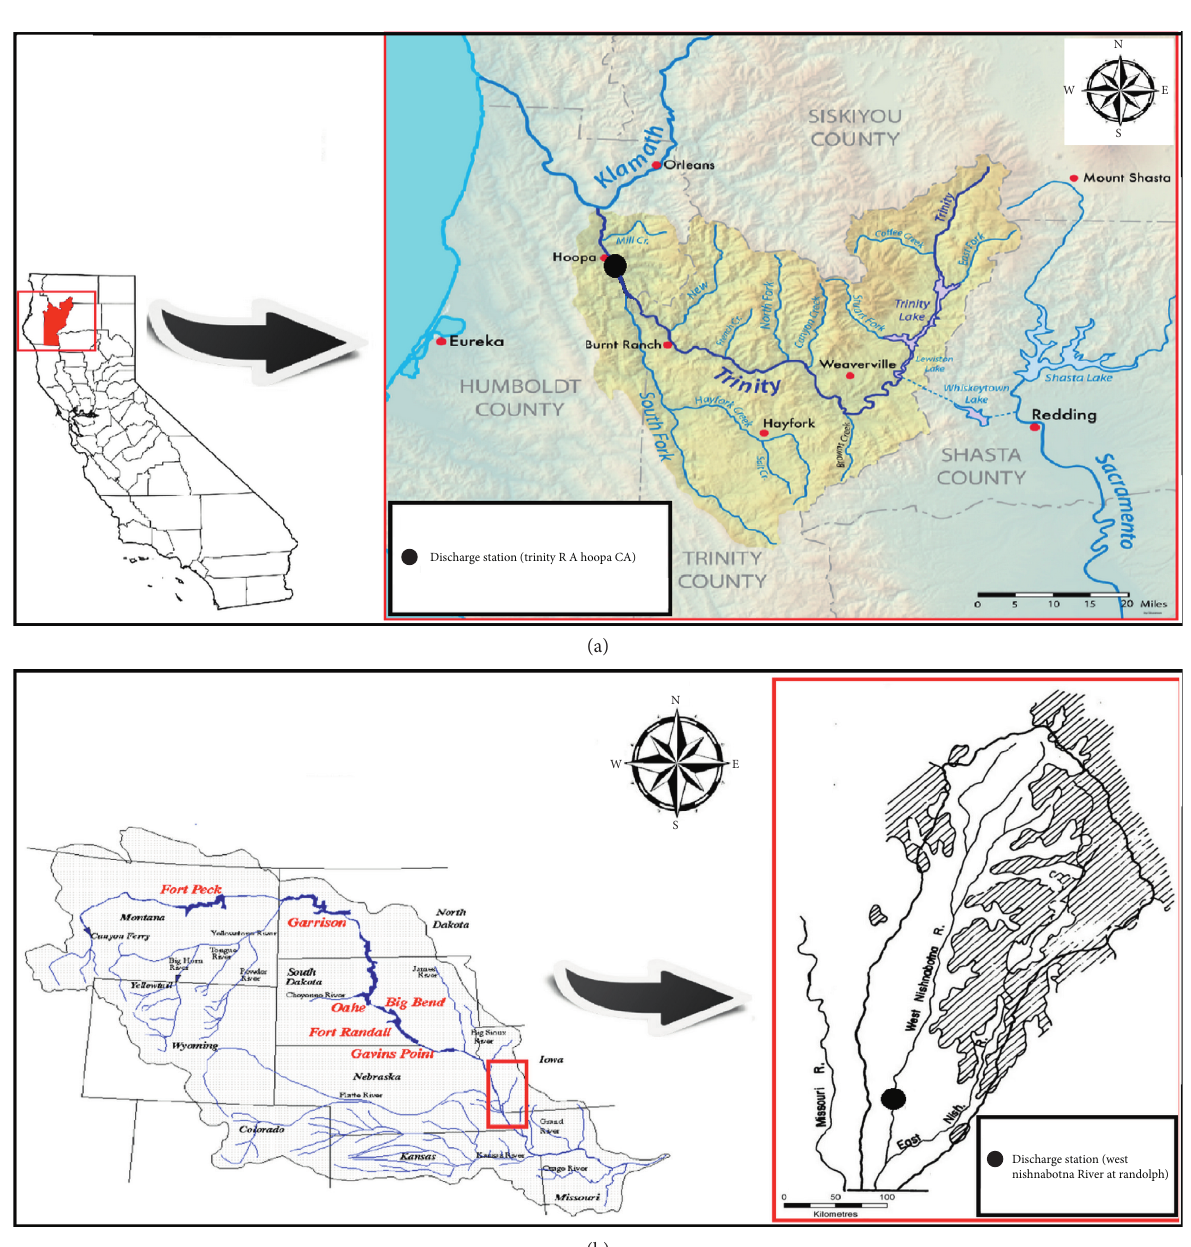
Figure 1: Rivers and stations of (a) Trinity and (b) West